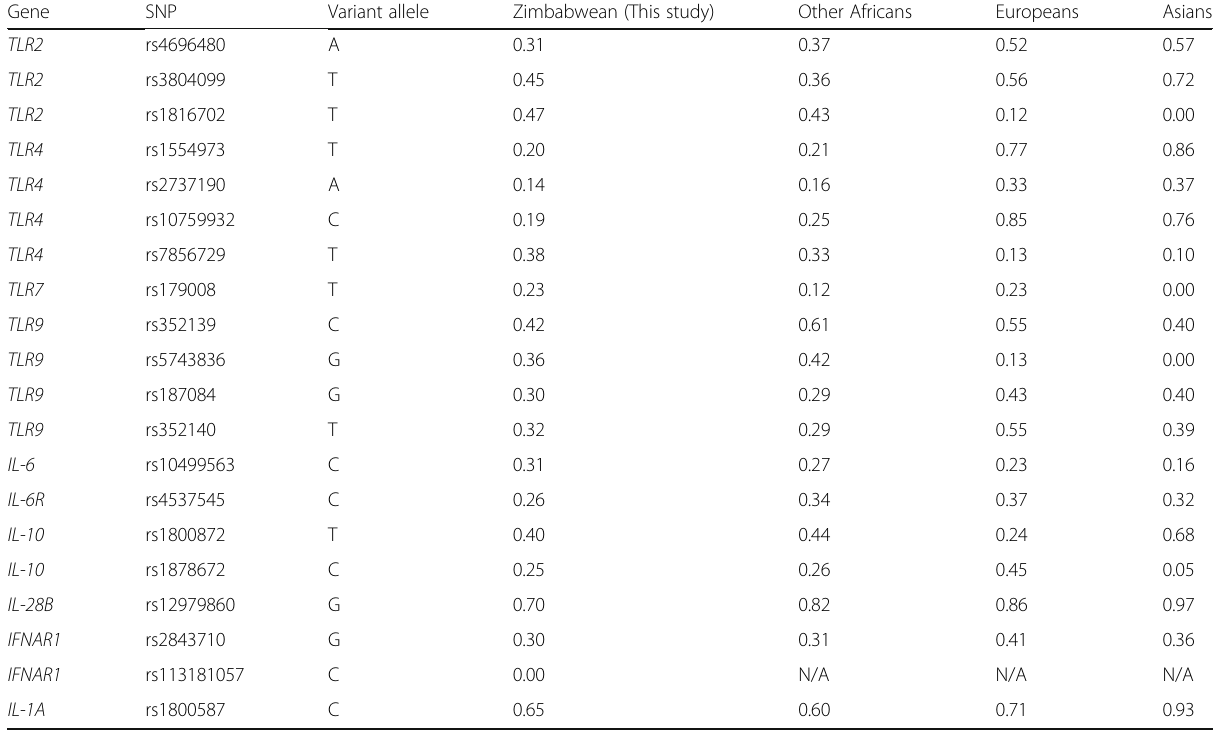
Table 4 Comparison of variant allele frequencies of genotyped SNPs with other populations Gene SNP Variant allele Zimbabwean (This study) Other Africans Europeans